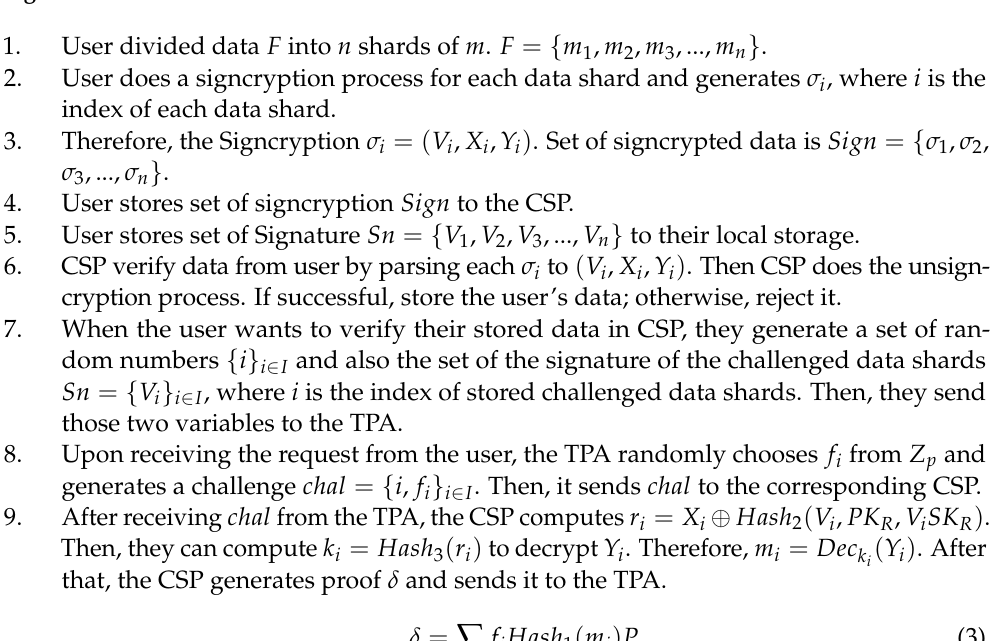
Figure 2. Data verification